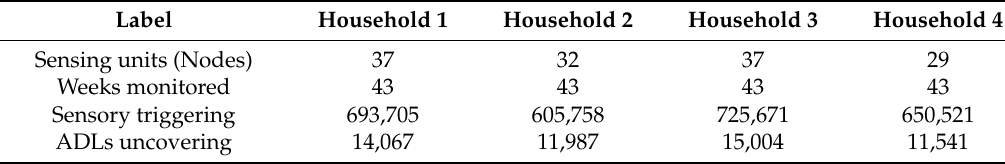
Table 2. Number of sensor activation and activity detection for four different houses equipped with hydrogenous sensing units.